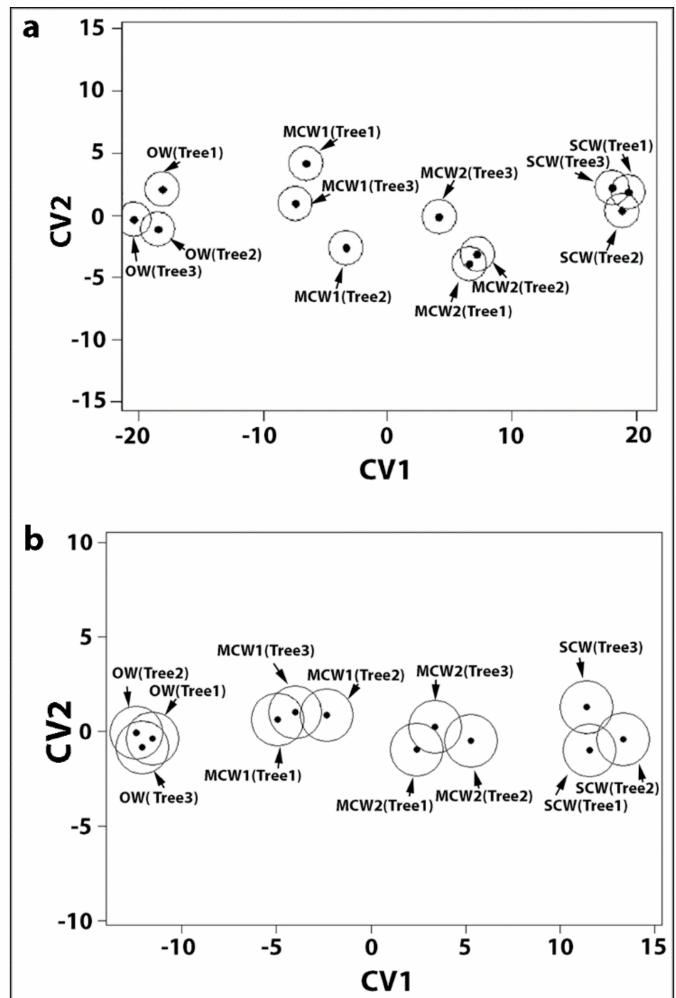
Figure 2. Canonical discriminant analysis (CDA) plot. ( a ) The four corewood types from three trees defined by the first two canonical variates (CV1 and CV2) obtained from CDA conducted on the shrinkage of the tracheids in the longitudinal, tangential and radial directions. The centroids for each corewood type of each tree with approximate 95% confidence regions are separated based on the differences in the shrinkage of the tracheids between corewood types and not trees. ( b ) The four corewood type from three trees defined by CV1 and CV2 obtained from CDA conducted on the tracheid cell-wall shrinkage (longitudinal shrinkage and transverse shrinkage of the radial and tangential walls). The centroids for each corewood type of each tree with approximate 95% confidence regions are separated based on the differences in the deformation of the tracheids on drying between corewood types and not